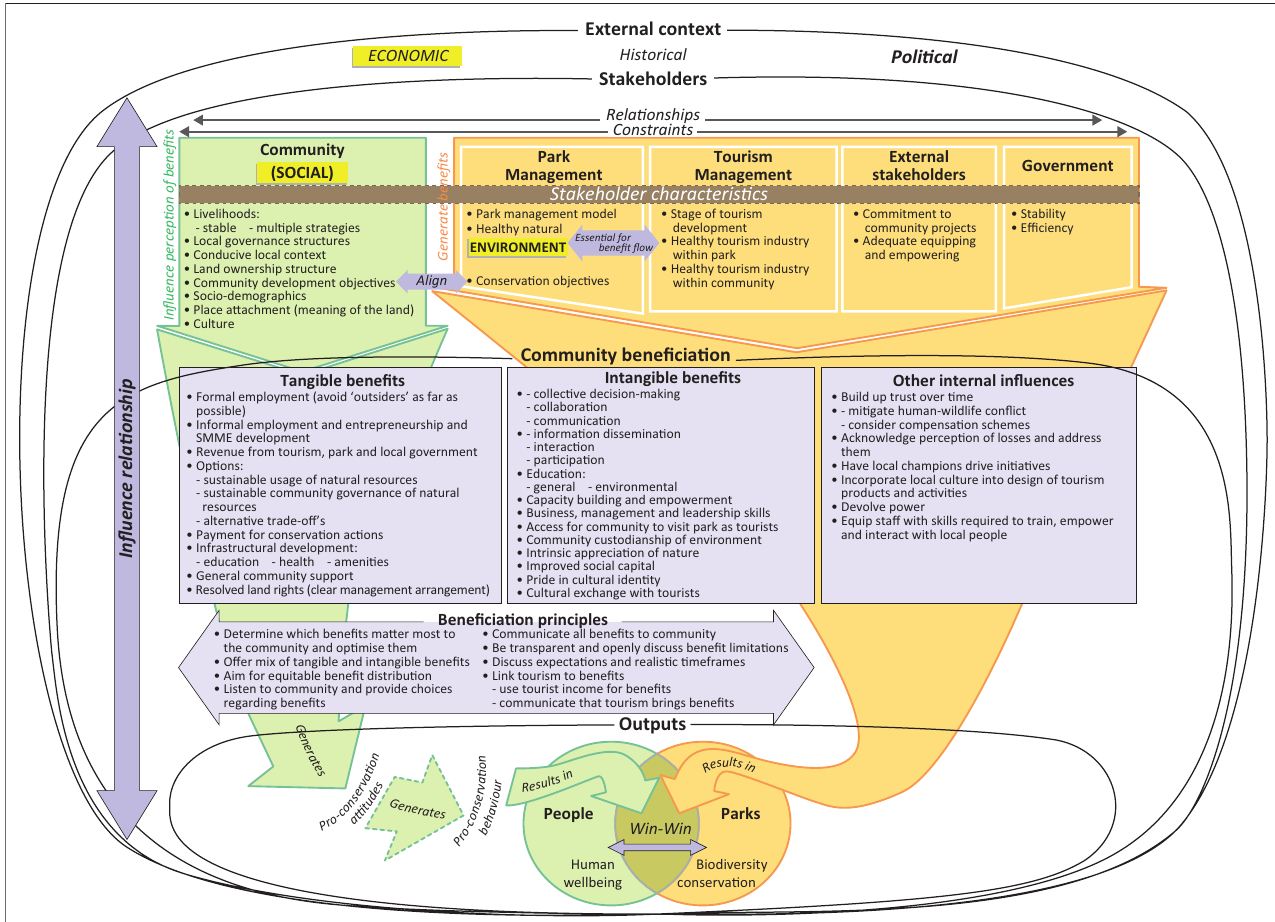
FIGURE 2: People Parks Win-Win